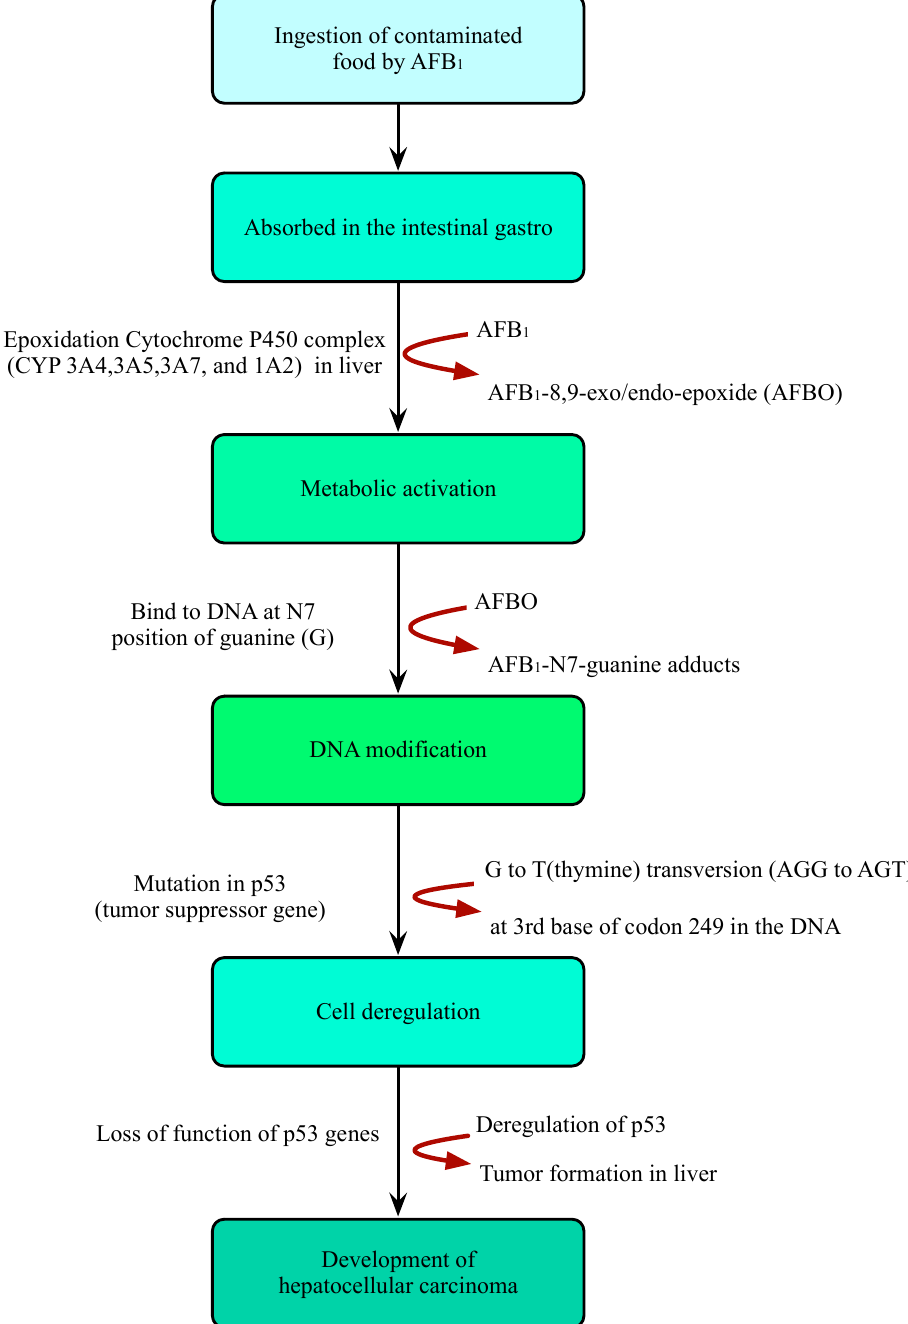
Figure 3. Illustration of the mechanism of hepatocellular carcinoma caused by ingestion of AFB 1 - contaminated foods.